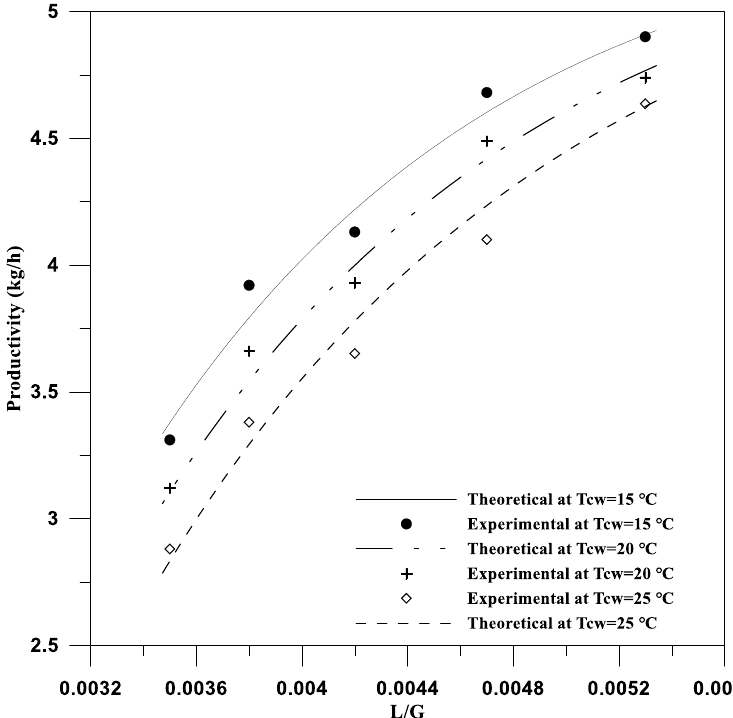
Figure 7. Productivity of the desalination unit using an ultrasonic atomizer system as a function of water to air mass ratios.